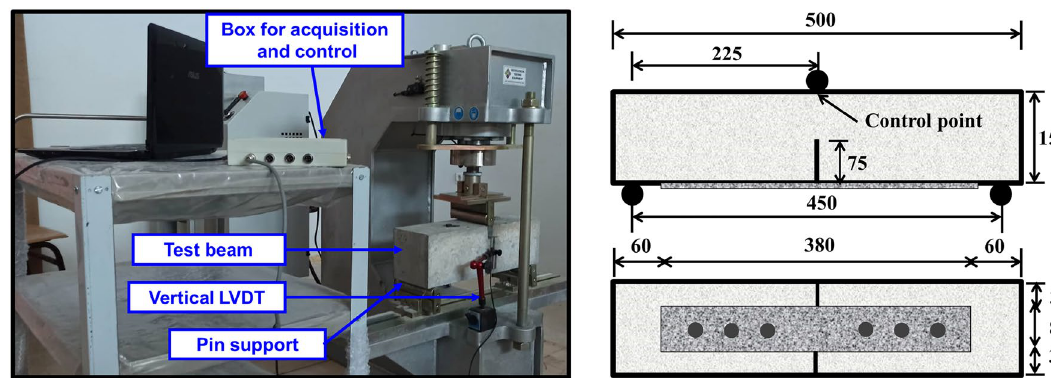
Fig. 3 Loading device and specimen dimension according to ASTM D7958/D7958M regulation (all dimensions in